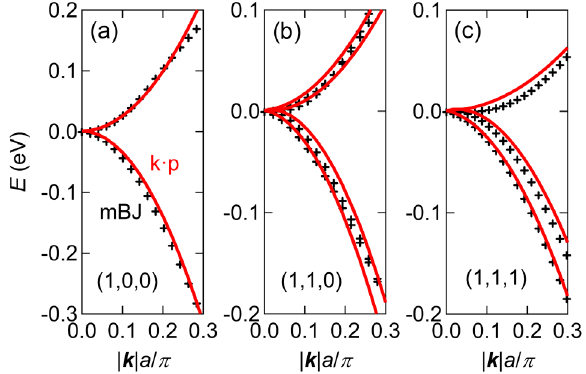
FIG. 5. Ab initio calculations and effective k · p model at low energies. First-principle results of energy dispersions (black crosses) along the (a) Γ -X, (b) Γ -K, and (c) Γ -L directions calculated for LuPdBi with a modified Becke-Johnson (mBJ) potential are fitted with the effective k · p model (red lines).